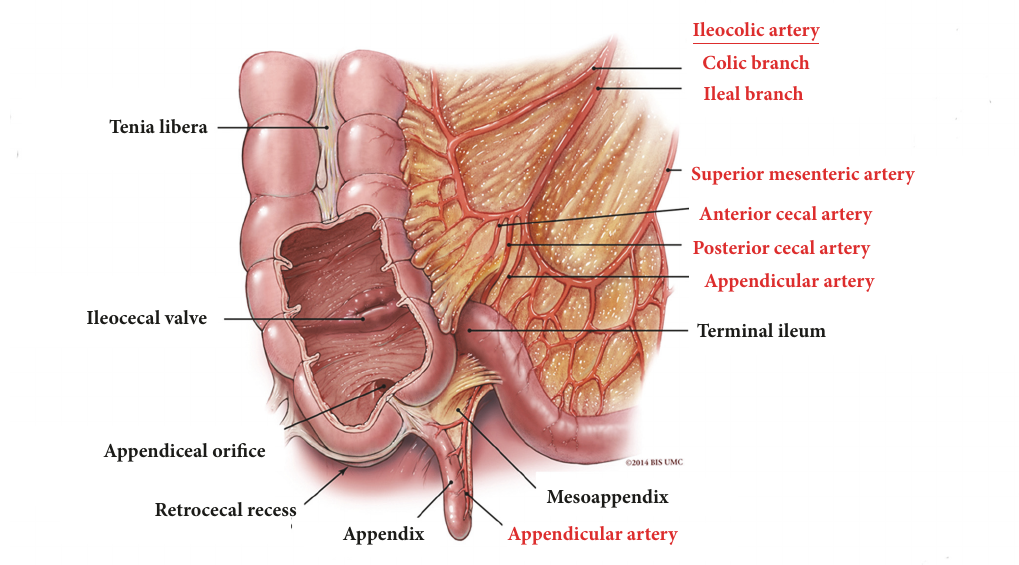
Figure 1: Illustration showing the anatomyand its vascularsupply of the ileocecum:terminal ileum, ileocecal valve, cecum,and the appendix. The superior mesenteric artery (SMA) supplies the ileum, cecum, and the ascending colon. SMA branches into ileal arteries and forms anastomotic loops or arcades. From these arcades, the straight arteries supply the small and large bowels. The appendix is supplied by the appendicular artery which arises from the terminal branch of the SMA instead of the arterial arcades.